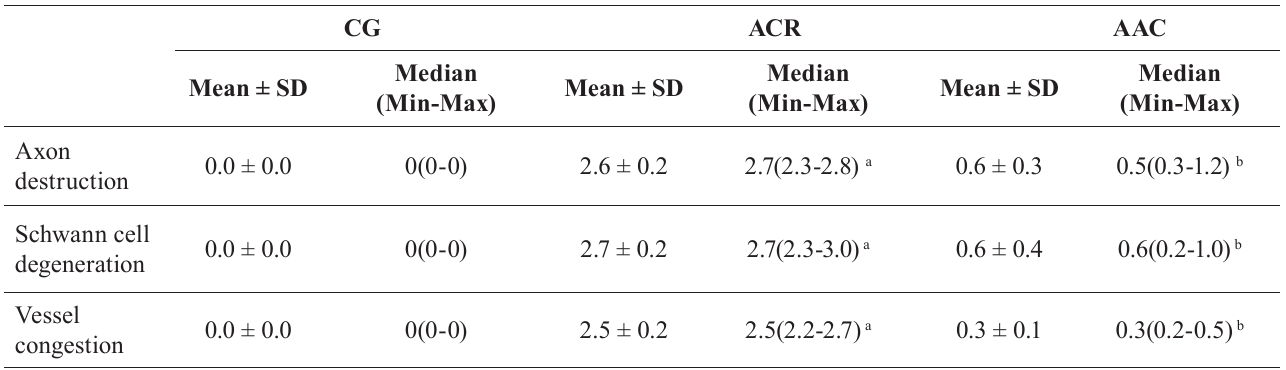
TABLE I - Q uantitative analysis of histopathological